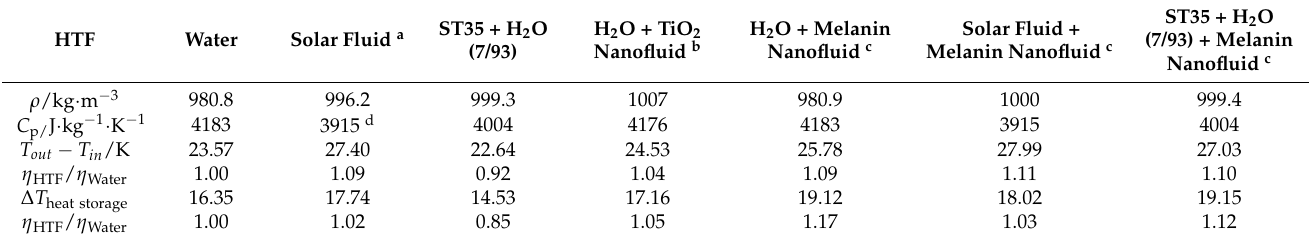
Table 2. Relative efficiency of the pilot heat collector for different heat transfer fluids and nanofluids. HTF